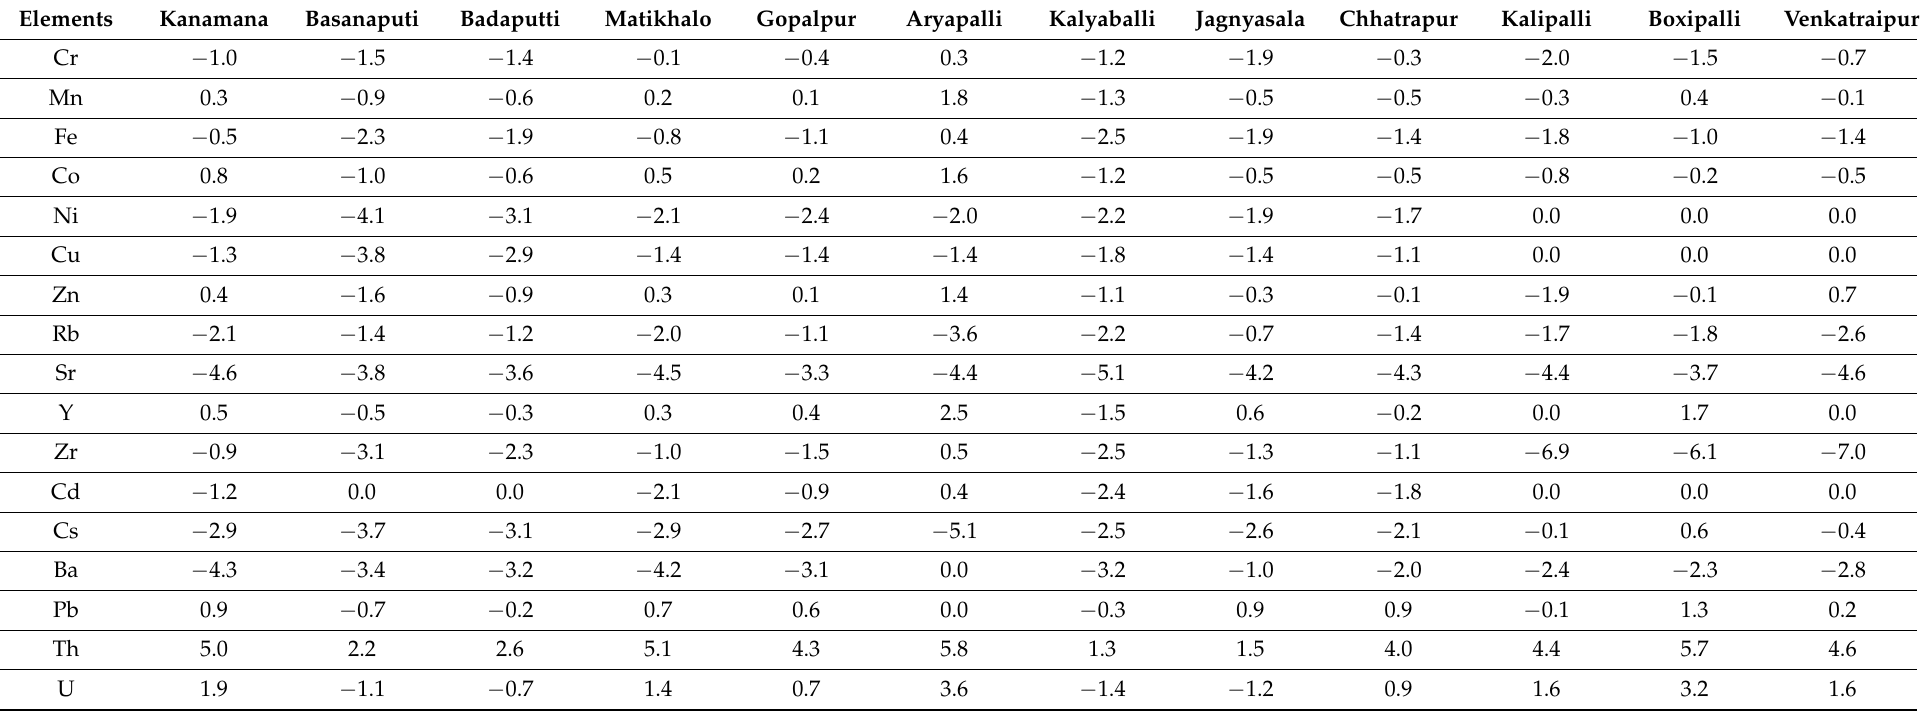
Table 4. Geoaccumulation index values of TEs in